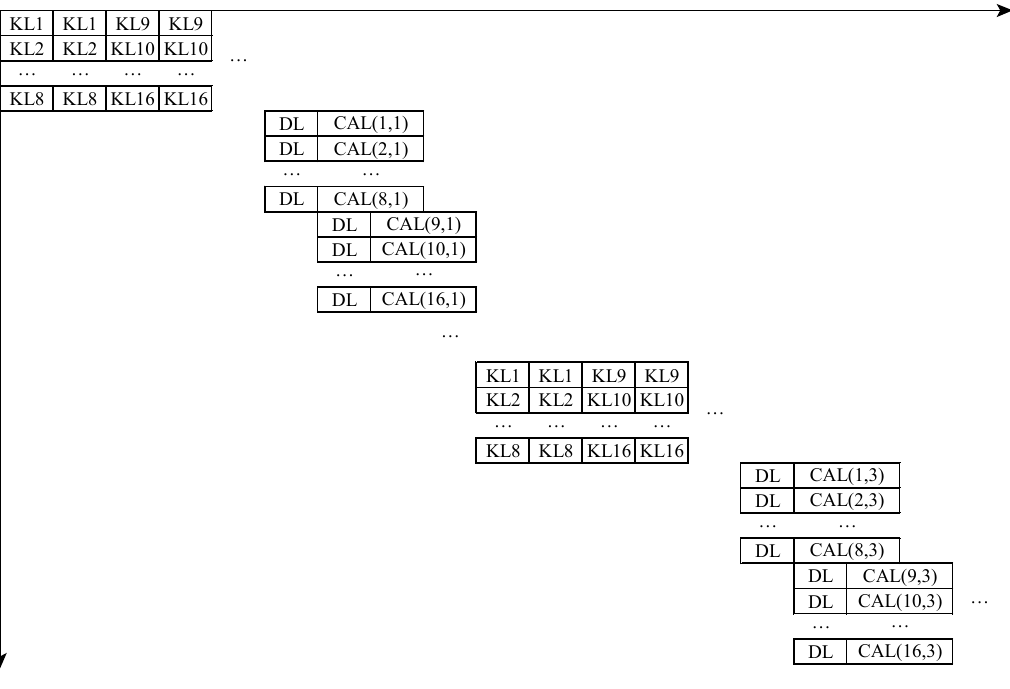
Figure 9. The second strategy of Full Connected layer.